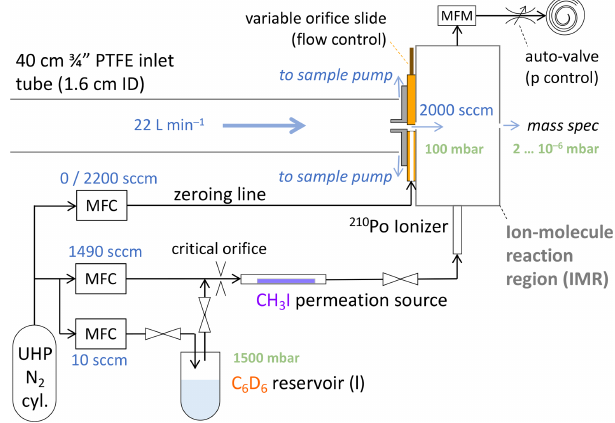
Figure 1. Schematic of the sampling setup and the flows into the IMR of the CIMS. The flows into the IMR are 1500sccm of ultra- high-purity (UHP) N 2 , set by mass flow controllers, and 2000sccm of sample, maintained by the variable orifice and controlled by mass flow controllers (MFCs) and mass flow meter (MFM) measure- ments (details in text). IMR pressure is maintained at 100mbar by the auto-valve in the pumping line. A fraction of the UHP N 2 passes over the headspace of a reservoir of liquid C 6 D 6 under ∼ 1500mbar due to a critical orifice; all N 2 then passes over a CH 3 I permeation device. Just prior to entering the IMR, a 210 Po ionizer provides the primary reagent ions: I − , C 6 D + and (C 6 D 6 ) + 6 2